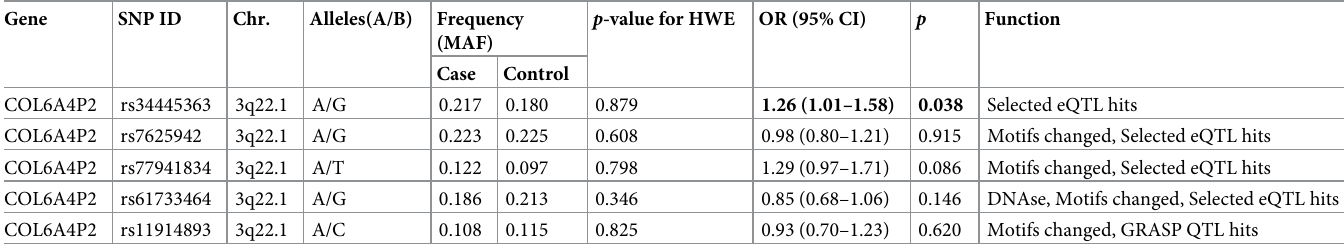
Table 2. Basic information about SNPs in COL6A4P2 and association with risk of lung cancer in allele model.